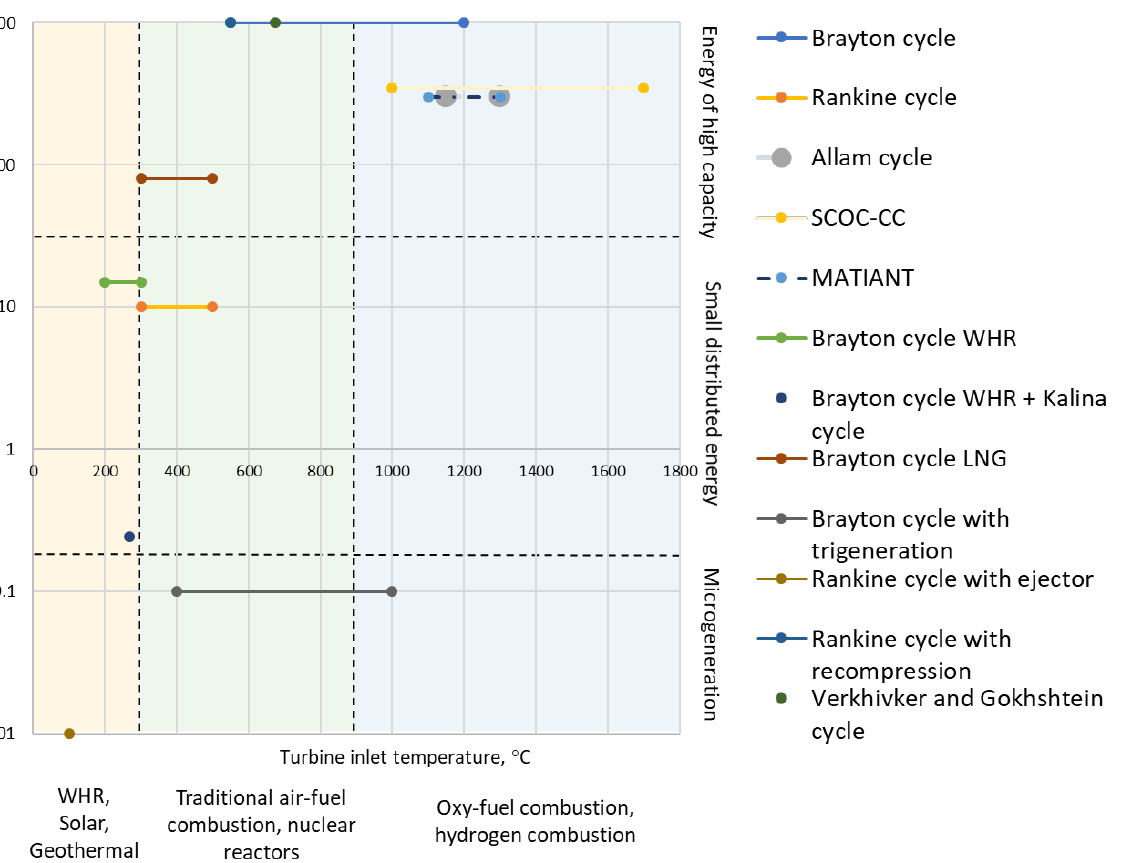
Table 3. Reference data for modern high-capacity thermal power plants.